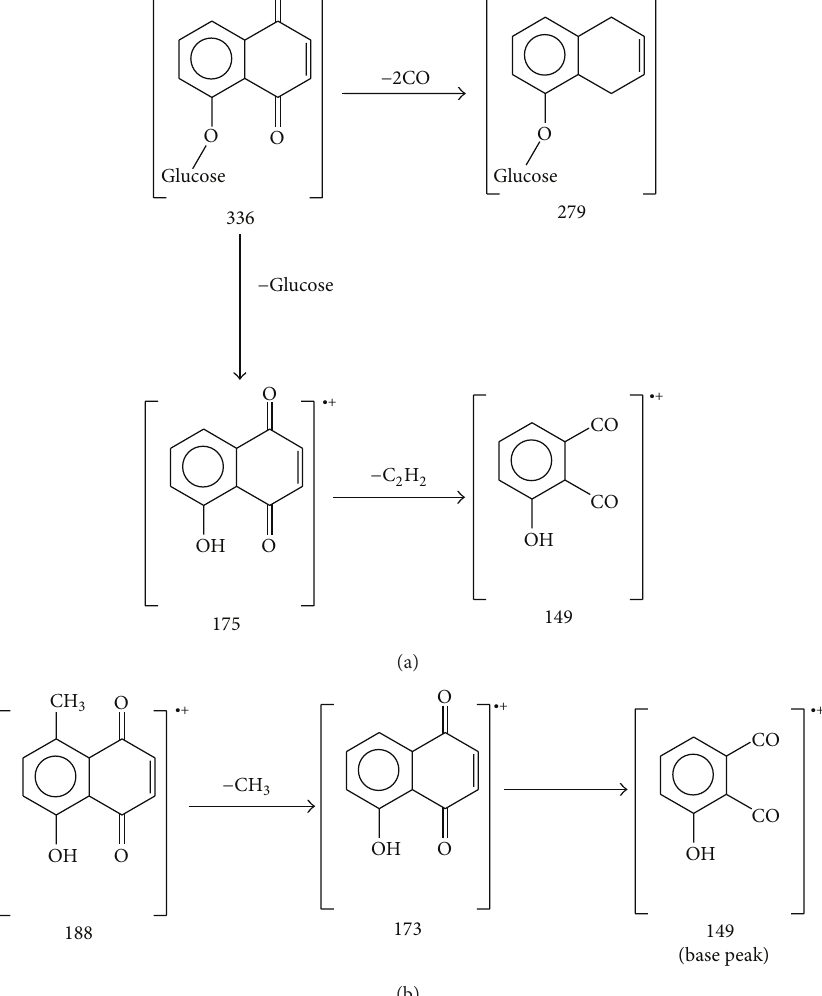
Figure 4: MS fragmentations of the extracted dye: (a) 𝑛 -hexane/petroleum ether (90: 10,v/v), 𝑅 𝑓 = 0.32 and (b) petroleum ether/diethyl ether (50 :50, v/v), 𝑅 𝑓 = 0.68